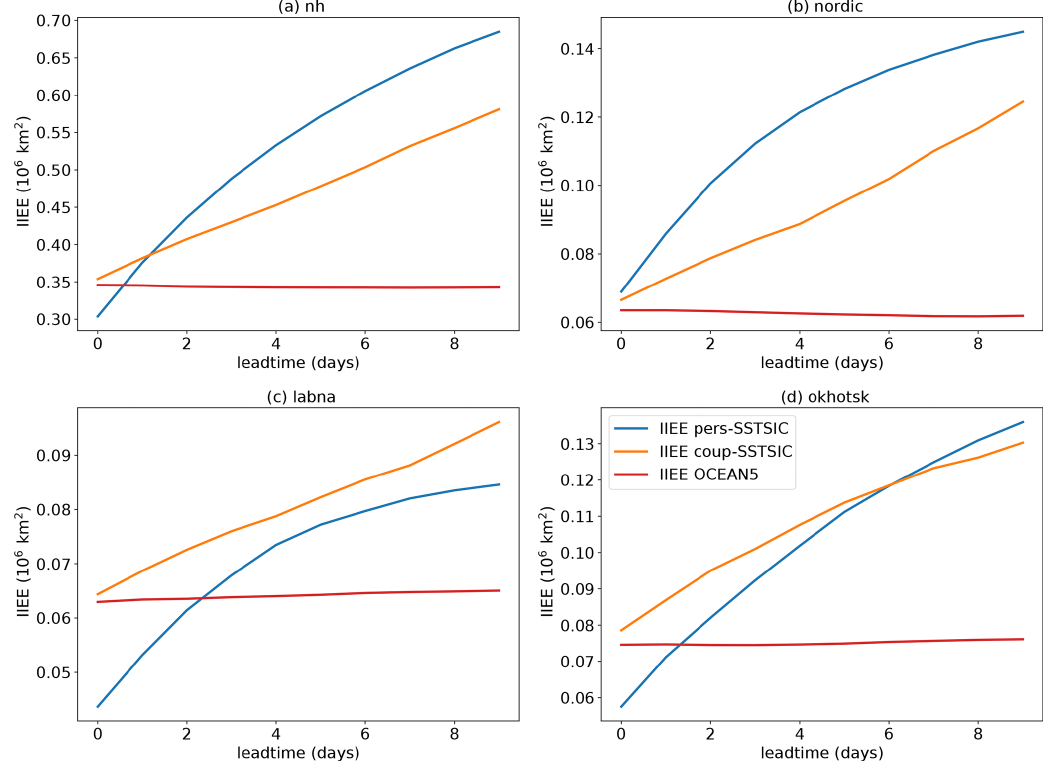
Figure 3. Average integrated ice edge error (IIEE) over all forecasts plotted against lead time, for the whole Northern Hemisphere (a) , the Nordic Seas (b) , and the Labrador–North-East Atlantic (c) and the Sea of Okhotsk (d) regions. These regions are shown in Fig. 1c and